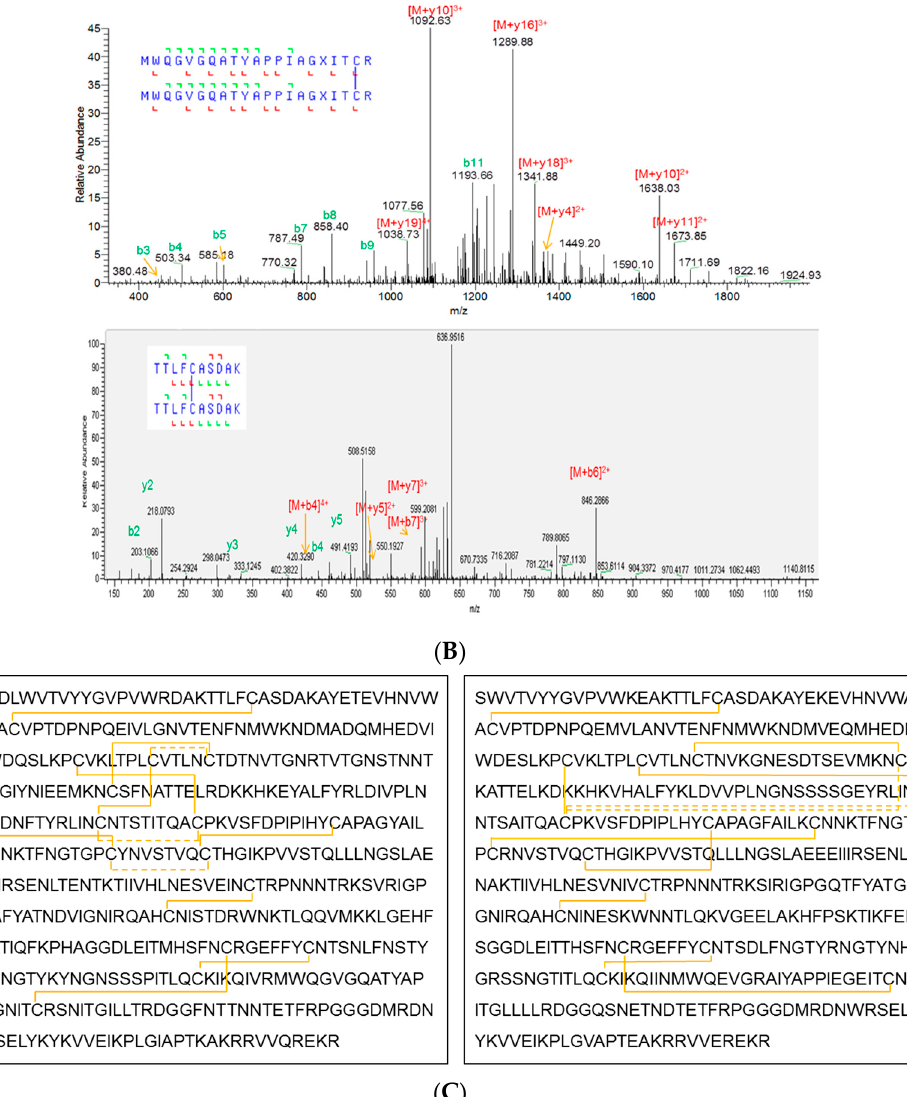
Figure 5. Characterization of disulfide bonding patterns in TV1.C and 1086.C gp120s. ( A ) Non-reduced SDS-PAGE showing presence of gp120 dimers. Lane 1, MW marker; Lane 2, 1086.C gp120; Lane 3, TV1.C gp120. ( B ) Inter-molecular disulfide bonding detected by LC-MS/MS, contributing to the formation of gp120 dimers. Upper panel, disulfide bonding between two identical peptides MWQGVGQATYAPPIAGXITCR in TV1.C gp120; lower panel, disulfide boding between two identical peptides TTLFCASDAK in 1086.C gp120. M refers to the intact peptide. ( C ) Diagrams showing the overall disulfide bonding patterns in TV1.C (left panel) and 1086.C (right panel) gp120. Solid lines, expected disulfide bond linkages; dotted line, alternative disulfide bond linkages.